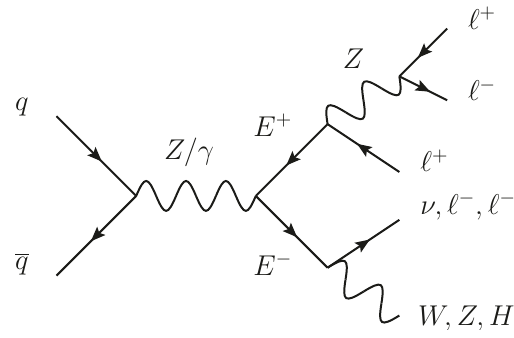
Figure 1 . Pair production of a VLL singlet E and decay channels our analysis is most sensitive